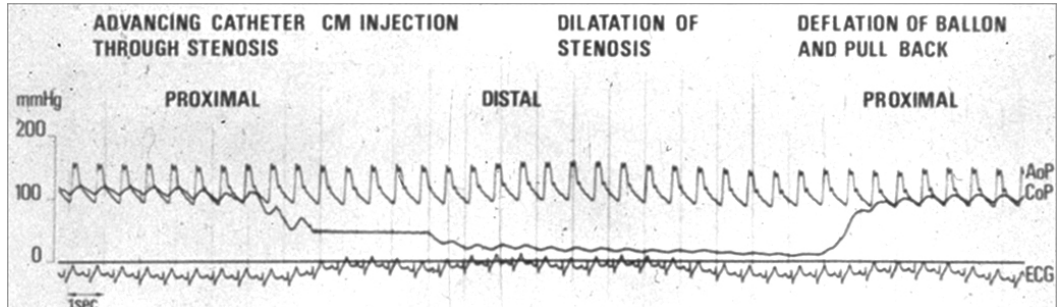
Figure 2. Coronary Artery Translesional Pressure Measurement in the First Angioplasty